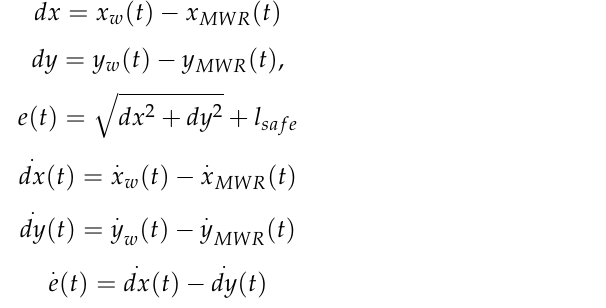
Figure 7. A Simulink model of the worker-following robot controller.